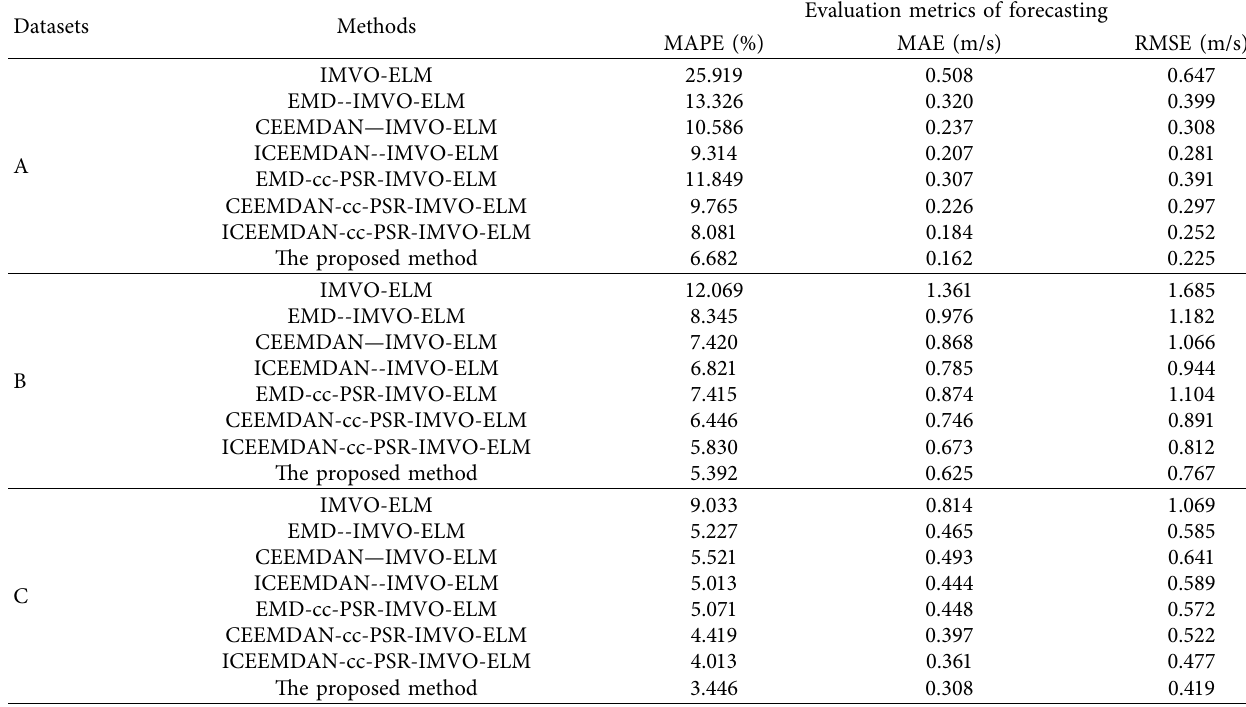
Table 3: The average evaluation metrics of forecasting by different methods with 20 times’ independent calculations.